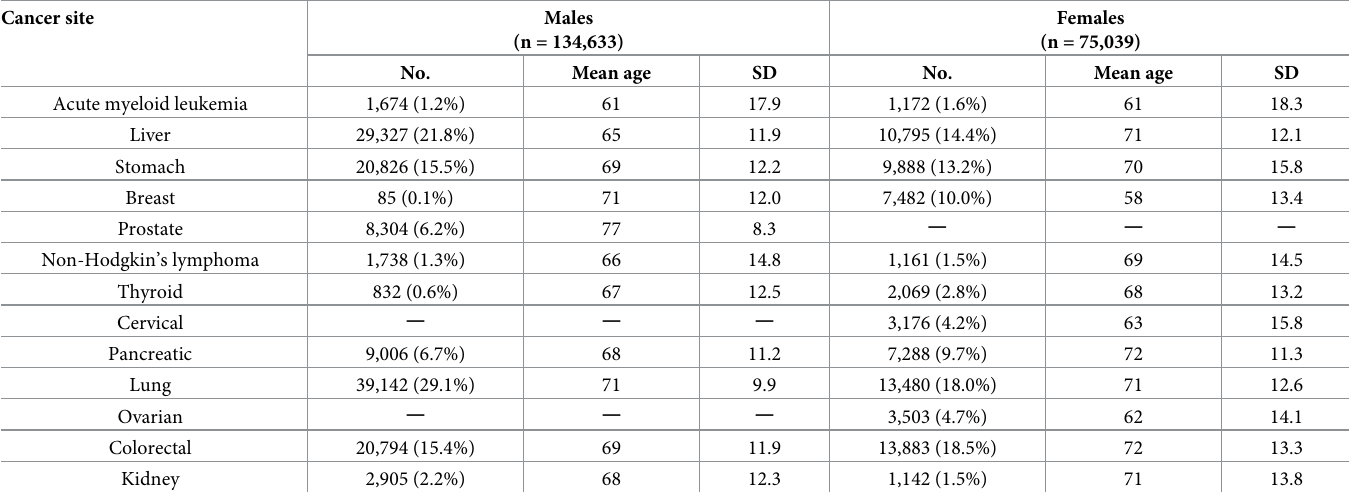
Table 1. Study subjects.